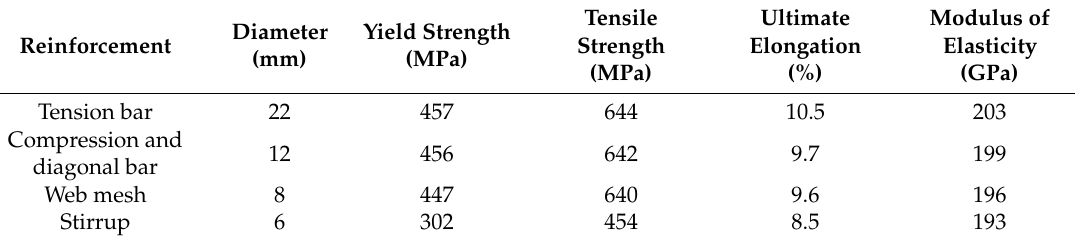
Table 3. Mechanical properties of the